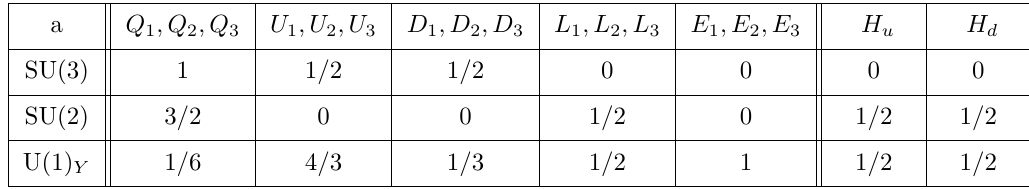
Table 2 . Values of T a K for all MSSM superfields. The index a numerates superfields, and K = SU(3) , SU(2) , U(1)